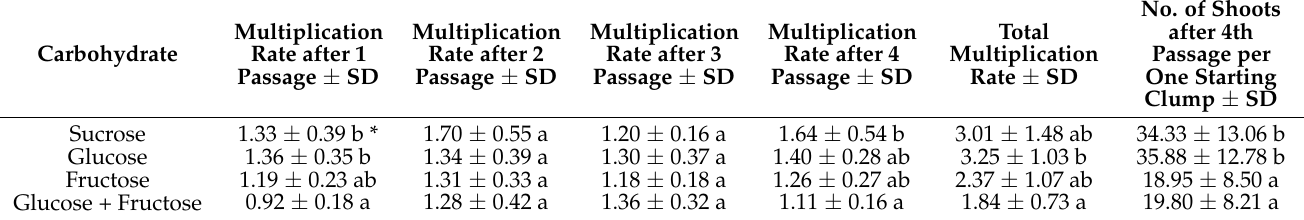
Table 3. Effects of different carbohydrates on in vitro shoot multiplication rate of the tulip cultivar ‘ Heart of Warsaw ’ .